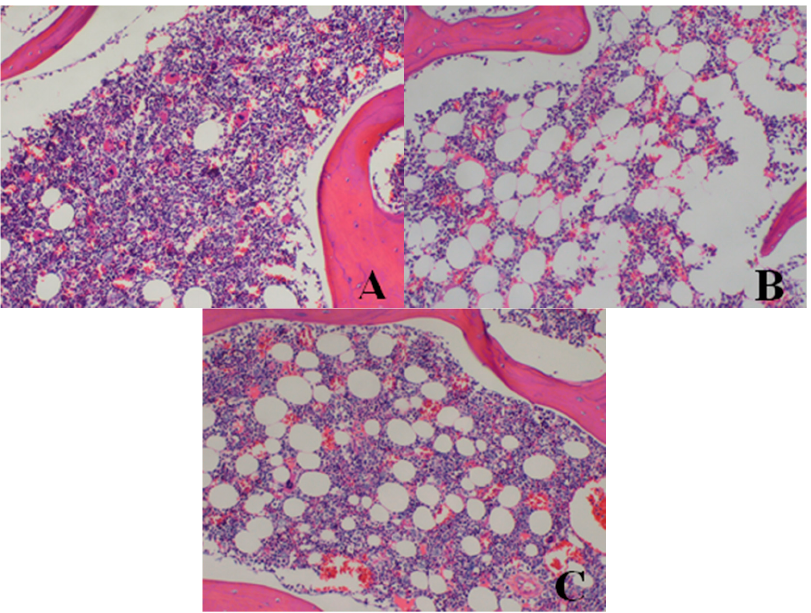
Figure 4. Hematoxylin and eosin-stained histologic sections of dogs’ bone marrow ( A – C ) (original magnification × 100). ( A ) Histopathological photomicrograph of bone marrow from ♀ 26 belonging to the control group at d28: normal; ( B ) Bone marrow from ♂ 5 belonging to the 80-mg/kg dose group at d28; ( C ) Bone marrow from ♂ 23 belonging to the 40-mg/kg dose group at d28. Note the increased fat vacuoles, decreased red bone marrow proportion, and increased yellow bone marrow ratio in the bone marrow. Images captured from sections prepared from the necropsy of dogs euthanized at d28.